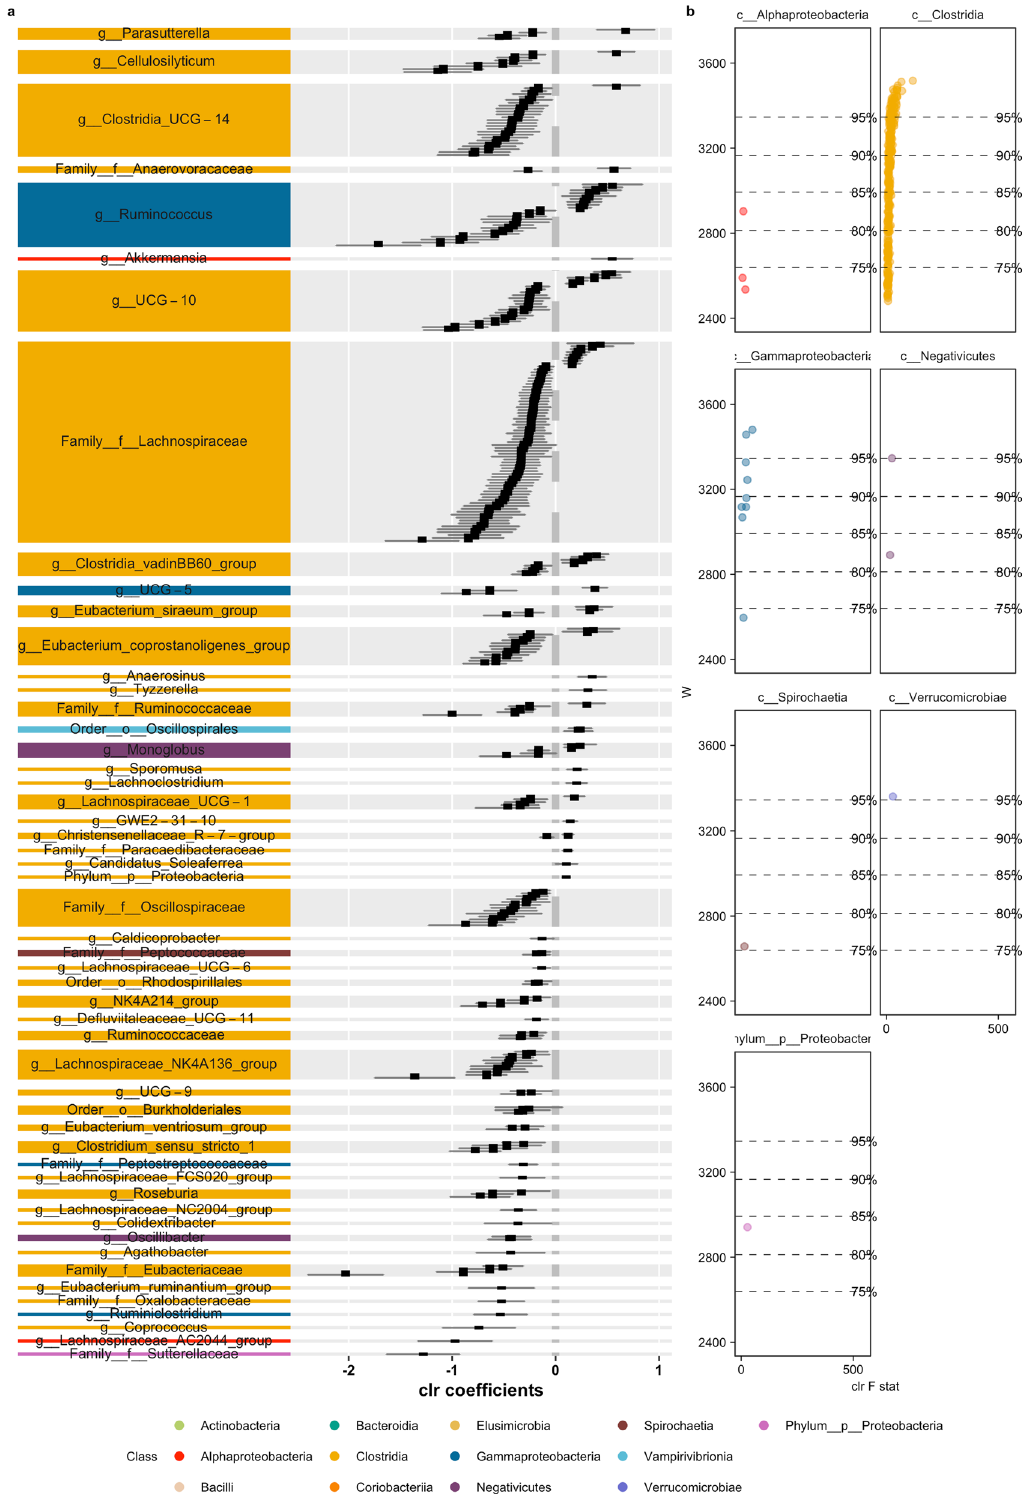
Fig. 8 Second half of differentially abundant ASVs (using ANCOM) in pairwise comparisons with landscape groupings based on similar responses in beta diversity to landscape modifications (Fig. 4) in P. semispinosus comparing landscape C represent the different bacterial classes. a Differential abundant ASVs according to the taxonomical assignment; b Volcano plot of differential abundant ASVs, depicting the F statistics and